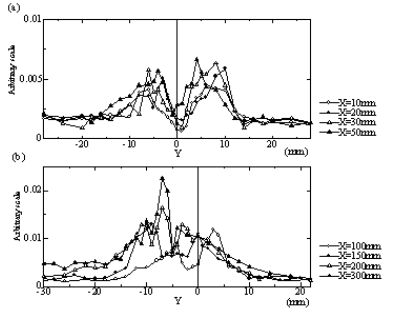
Fig. 16 Amplitude distribution of 1/4 subharmonics (natural);(a)X=10-50mm,(b)X=100-300mm.